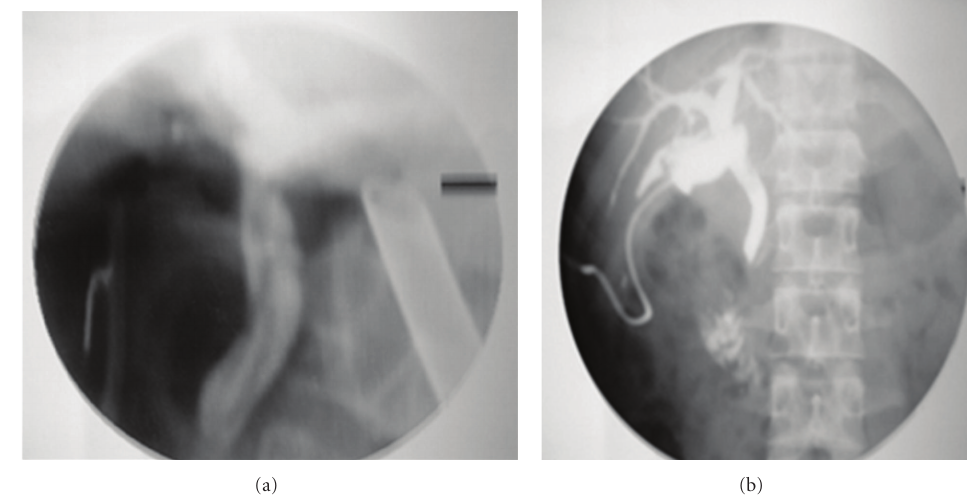
Figure 3: (a) PerOp cholangiogram before extraction of worm, (b) after extraction of